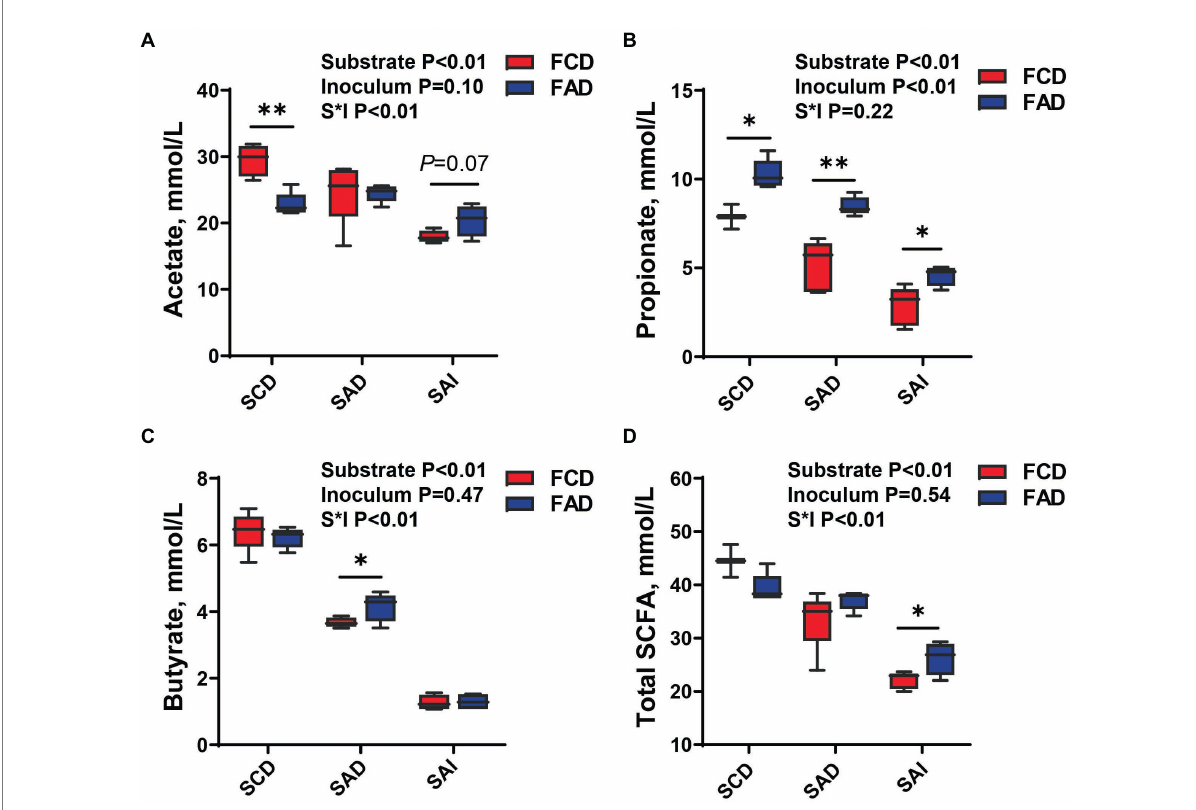
FIGURE 8 SCFA production during in-vitro fermentation of different substrate using feces from pigs fed different diets. Concentration of (A) Acetate, (B) Propionate, (C) Butyrate, and (D) Total SCFA. * p < 0.05, ** p < 0.01. FCD, feces of CD group; FAD, feces of AD group; SCD, substrate of control diet; SAD, substrate of alfalfa diet; SAI, substrate of alfalfa